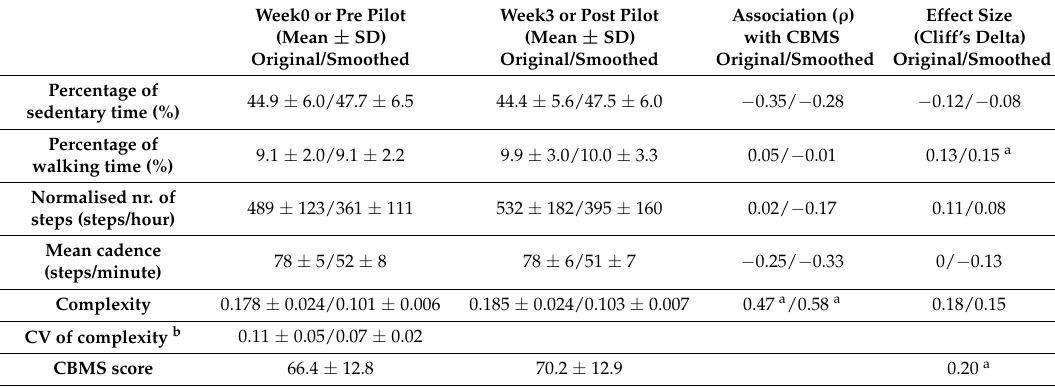
Table 1. Descriptive statistics of PA metrics, complexity, and CBMS scores in pre- and post- intervention assessments. PA metrics and complexity based on original and smoothed PA time series are compared with CMBS scores.